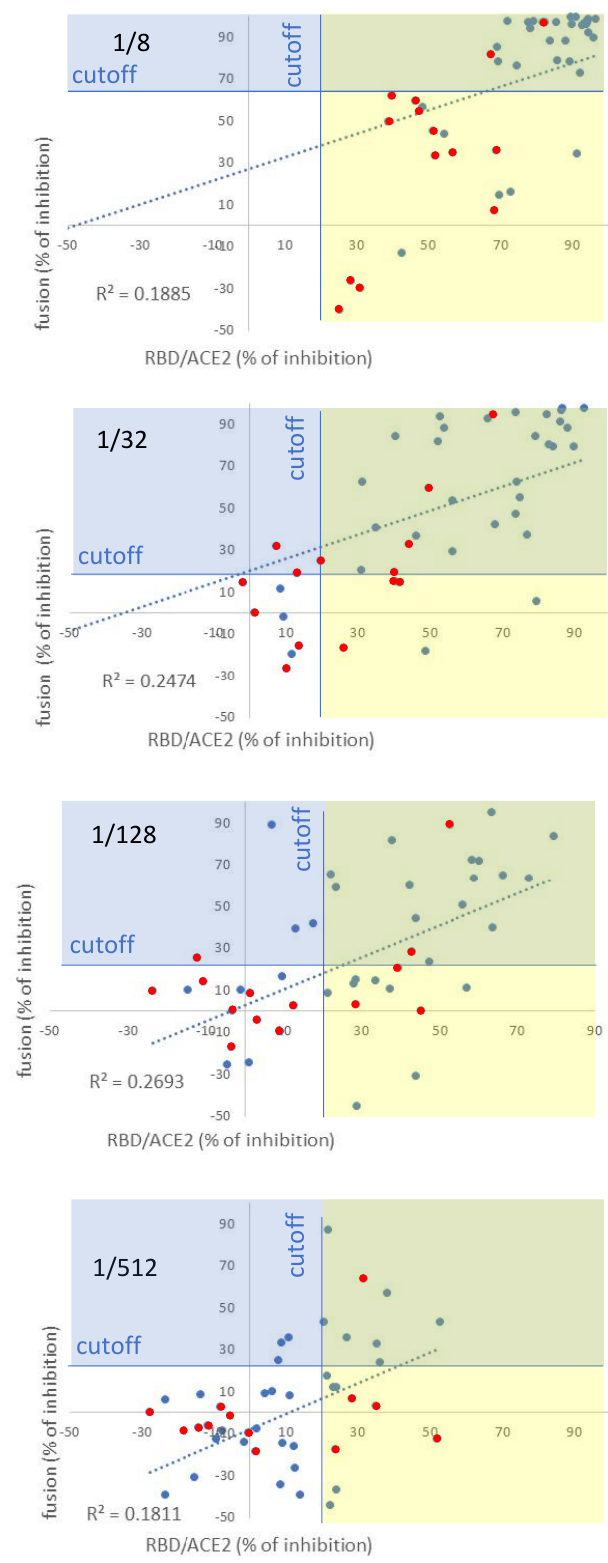
Figure 5. Comparison of the fusion-based assay with a competitive ELISA measuring the RBD/ACE2 interaction. In total, 47 sera were either analyzed, for each dilution, with the fusion-based assay or a competitive ELISA measuring the RBD/ACE2 interaction. The cut-off value for the ELISA is 20% of inhibition (as indicated by the